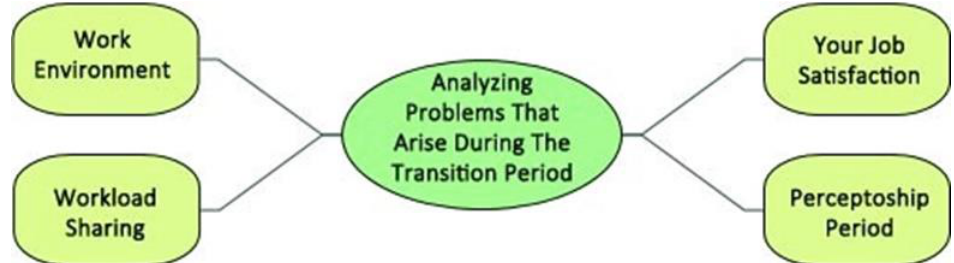
Fig. 5. Themes and sub-themes of problems arising during the transition period